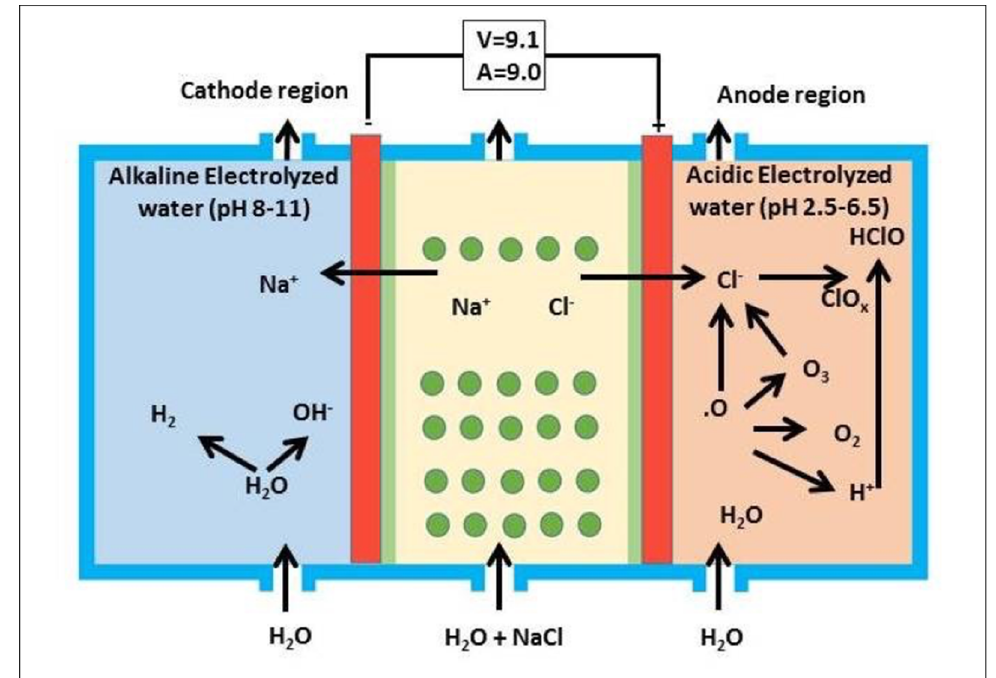
Figure 1. A three-chamber double-in electrolytic system device incorporating an electrolytic apparatus (Redox Technology Ltd. Co., Tokyo, Japan).